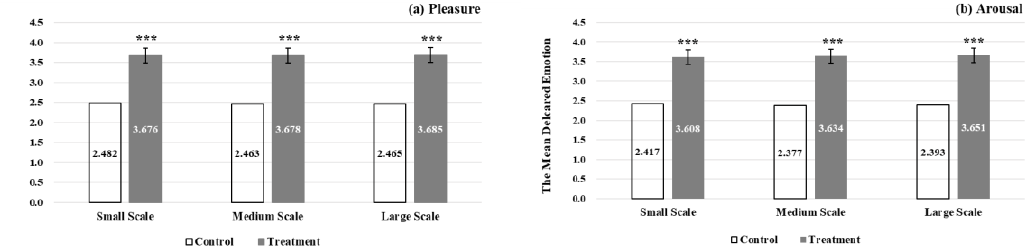
Figure A1. The impact of the three scales of intervention on tourists’ momentary emotional experience; ( a ) pleasure, ( b ) arousal. Note: Error bars represent 95% confidence interval. *** p < 0.001.